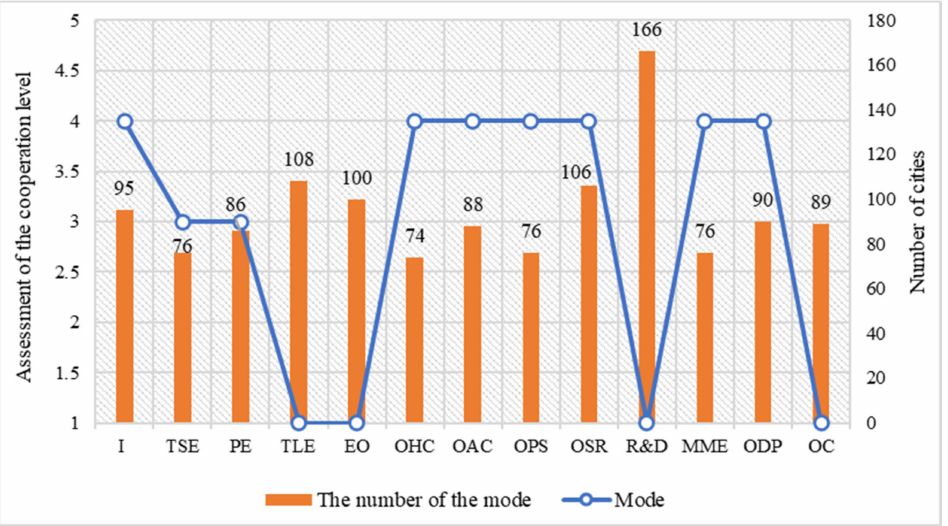
Figure 6. Dominant (mode) and its number in the examined group of